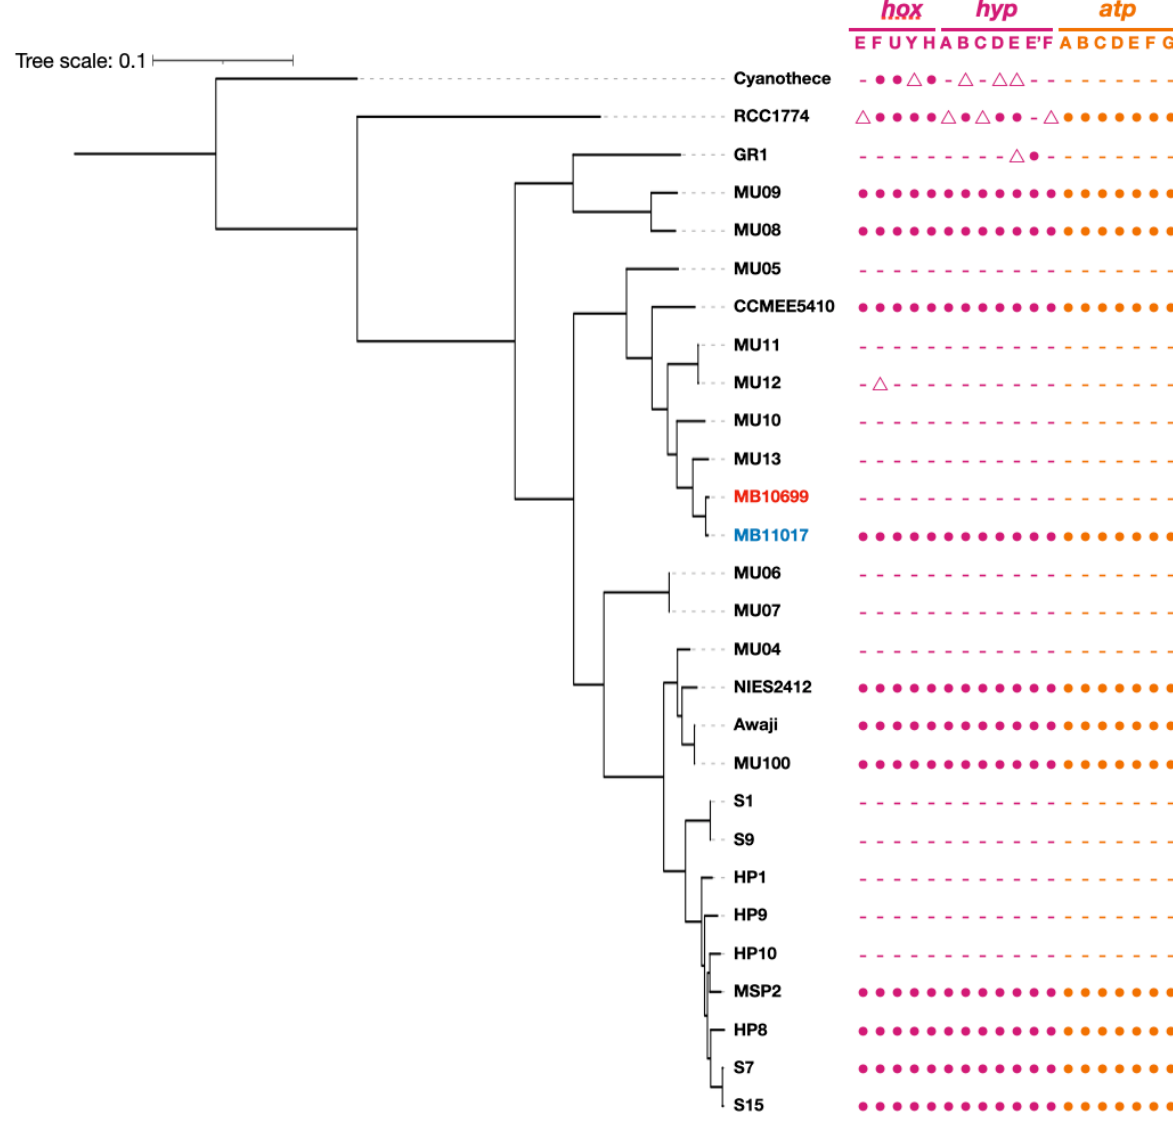
Figure 3. Phylogenic tree of Acaryochloris species. A maximum likelihood phylogenic tree of Acary- ochloris strains was constructed from genome-wide concatenated protein sequences from single copy orthologous genes ( n = 897). The tree was outgroup-rooted with Cyanothece sp. PCC7425 (Cyanoth- ece). Another sister group of Acaryochloris strains, Acaryochloris thomasi RCC1774 (RCC1774), which biosynthesizes Chl b instead of Chl d , was used along with previously reported Acaryochloris strains. A. marina MBIC10699 and MBIC11017 are highlighted in red and blue, respectively. The symbols indicate the presence or absence of genes with significant homology to hoxEFUYH / hypABCDEE’F (purple) and atpABCDEFG (orange) genes encoded in pREB4 of MB11017 in each strain. Circles indicate the conservation of genes with significant homology (e-value < 1 × 10 − 100 ), and triangles indicate genes that show some degree of homology with e-values between 1 × 10 − 100 and 1 × 10 − 50 .